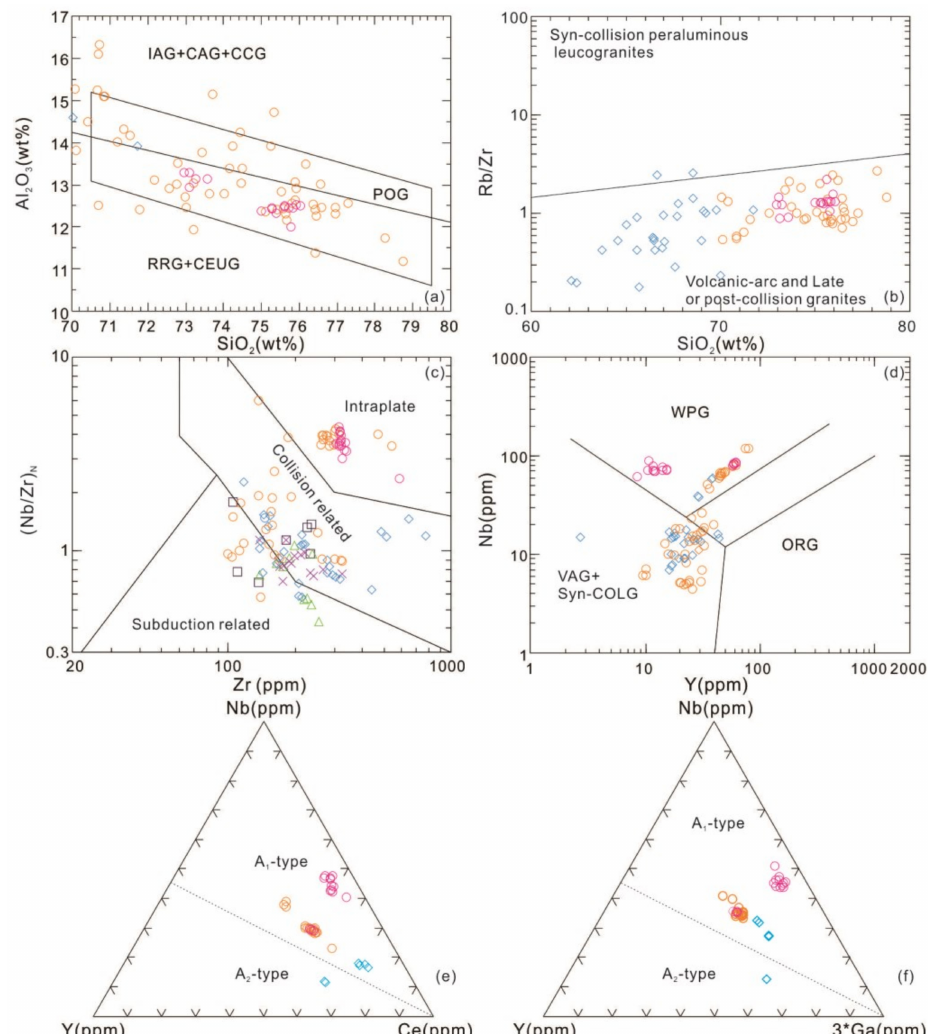
Figure 12. Diagrams of the tectonic settings of the Keri rhyolites in the EKOB. ( a ) after Maniar et al. [72]; ( b ) after Harris et al. [115]; ( c ) after Thi é blemont et al. [116]; ( d ) after Pearce et al. [86]; ( e , f ) after Eby [80]. VAG = volcanic arc granites; Syn-COLG = syn-collision granites; WPG = within- plate granites; ORG = ocean ridge granites; Post-COLG = post-collision granites; MORB = mid- ocean ridge basalt; OIB = oceanic island basalts; WPB = within-plate basalts; IAB = island-arc tholeiites; MORB = mid-ocean ridge basalts; IAG = island arc granitoids; CAG = continental arc granitoids; CCG = continental collision granitoids; POG = post-orogenic granitoids; RRG = rift-related granitoids; CEUG = continental epeirogenic uplift granitoids. A 1 -type = anorogenic environment; A 2 -type = post-orogenic